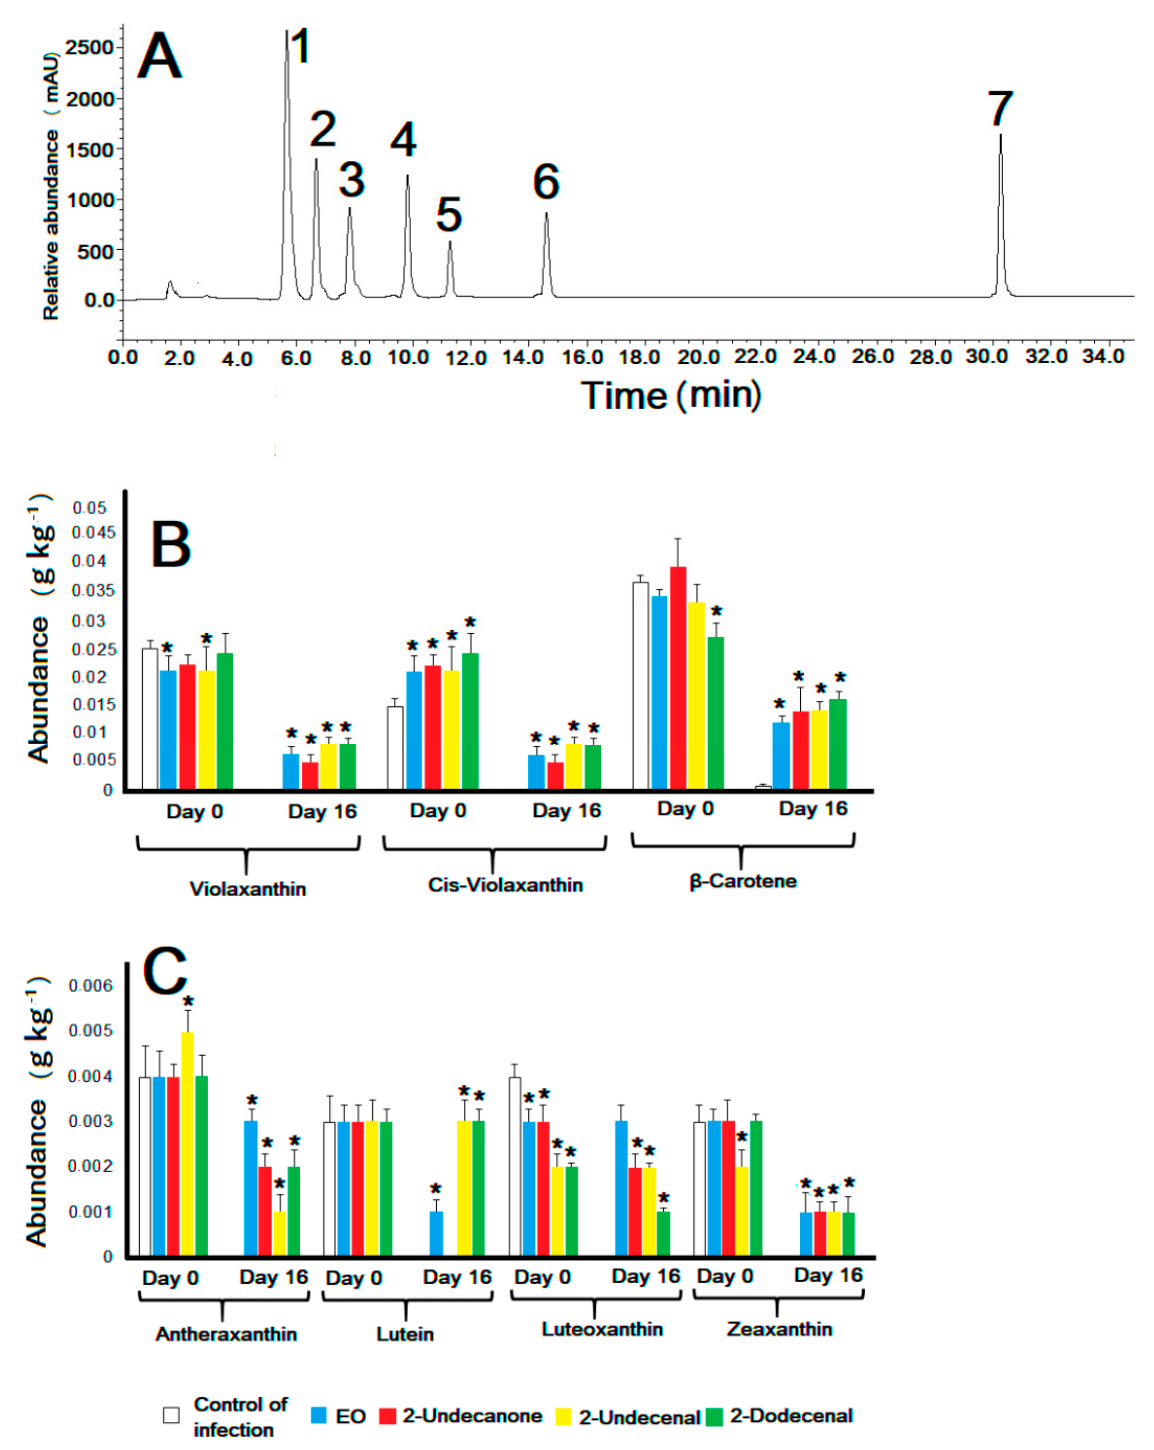
Figure 8. HPLC-MS profiling of the carotenoids contained in manzano peppers grown in Puebla- Mexico ( A ). The protective effect of 120 mg L − 1 ZlEO, 150 mg L − 1 2-undecanone, 220 mg L − 1 2-undecenal, and 130 mg L − 1 2-dodecenal on the levels of violaxanthin ( B ), cis-violaxanthin ( B ), beta- carotene ( B ), antheraxanthin ( C ), lutein ( C ), luteoxanthin ( C ), and zeaxanthin ( C ) and are compared between day cero, and the sixteenth day post-inoculation. * Indicates means (n = 20) with statistically significant differences ( p < 0.05) in comparison with the controls of infection. The peak numbers correspond to the compounds specified in Table S9.